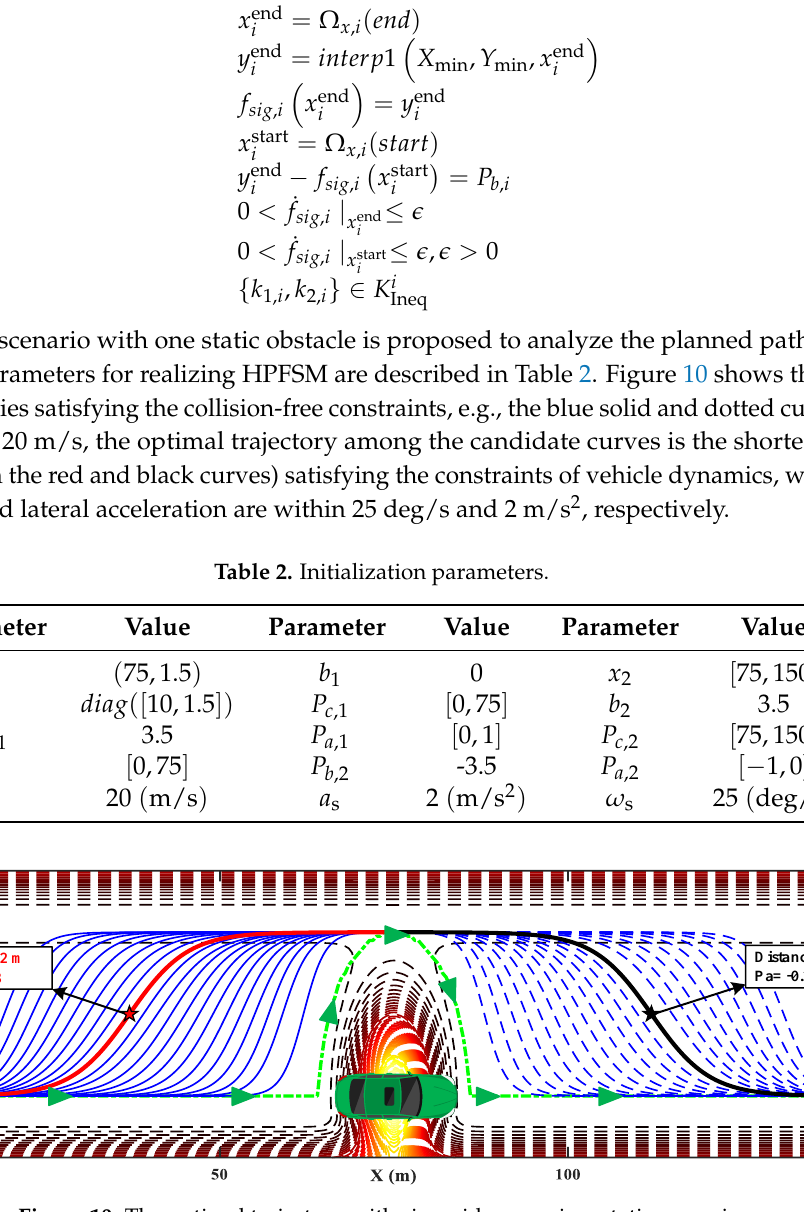
Figure 10. The optimal trajectory with sigmoid curves in a static